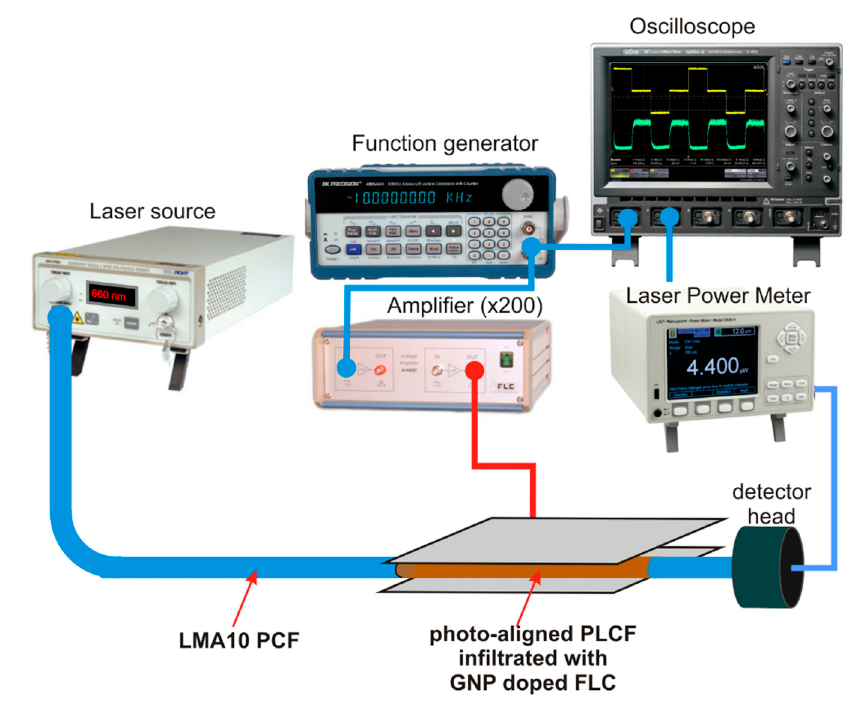
Figure 6. The experimental setup used for electro-optical studies.